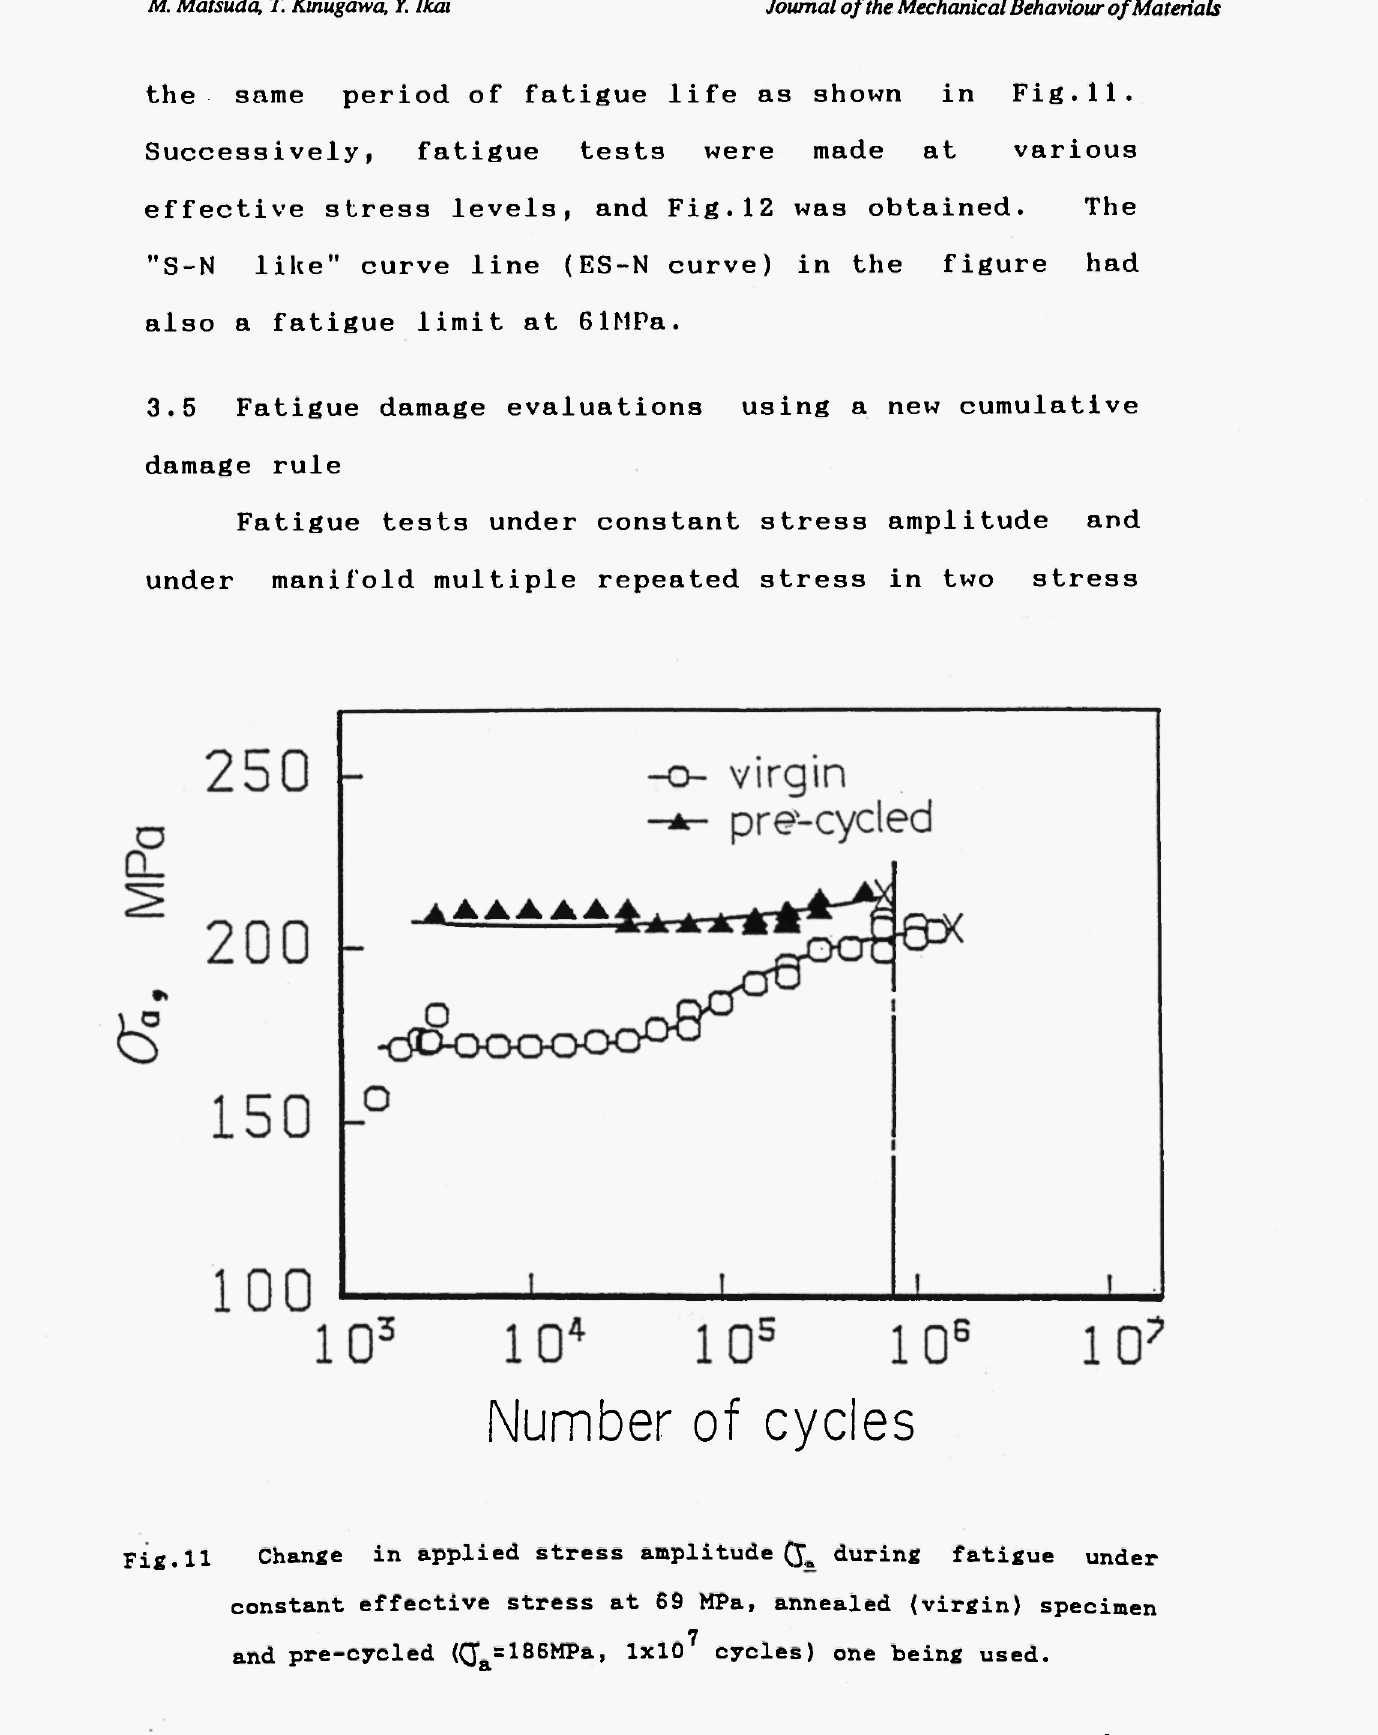
Fig.11 Change in applied stress amplitude (J during fatigue under constant effective stress at 69 MPa, annealed (virgin) specimen 7 and pre-cycled (^sieeMPa, 1x10 cycles) one being